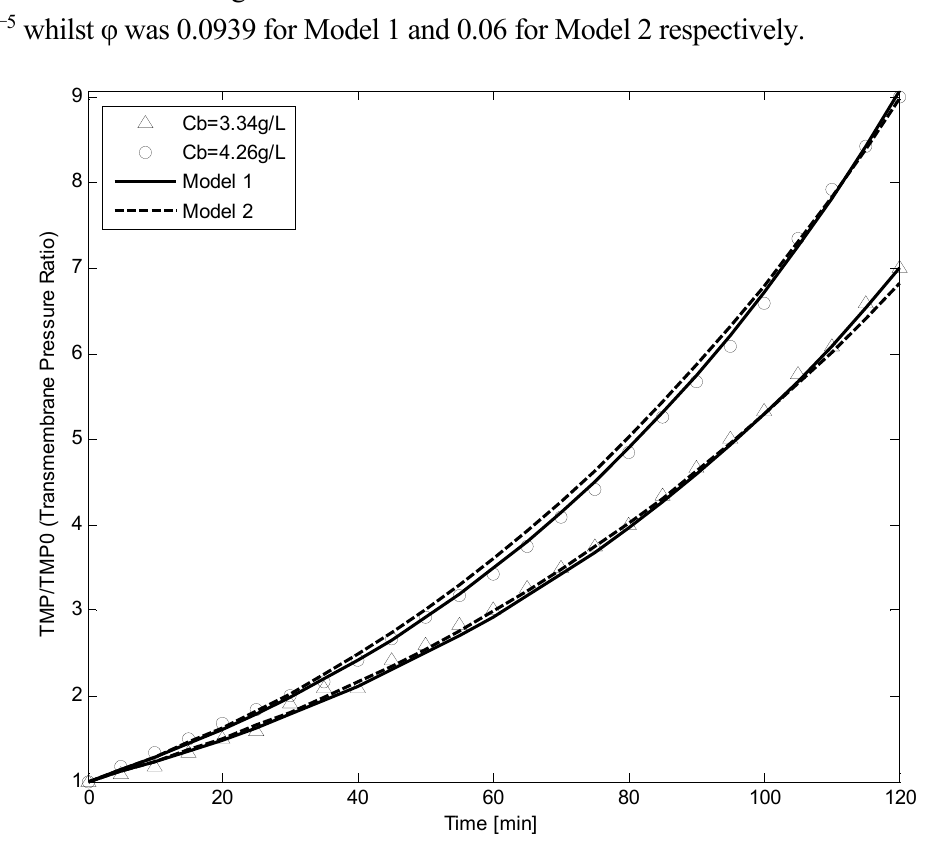
Figure 10. TMP plotted against filtration time at constant flow rate of 8.67 × 10 − 6 m 3 /s for rotating